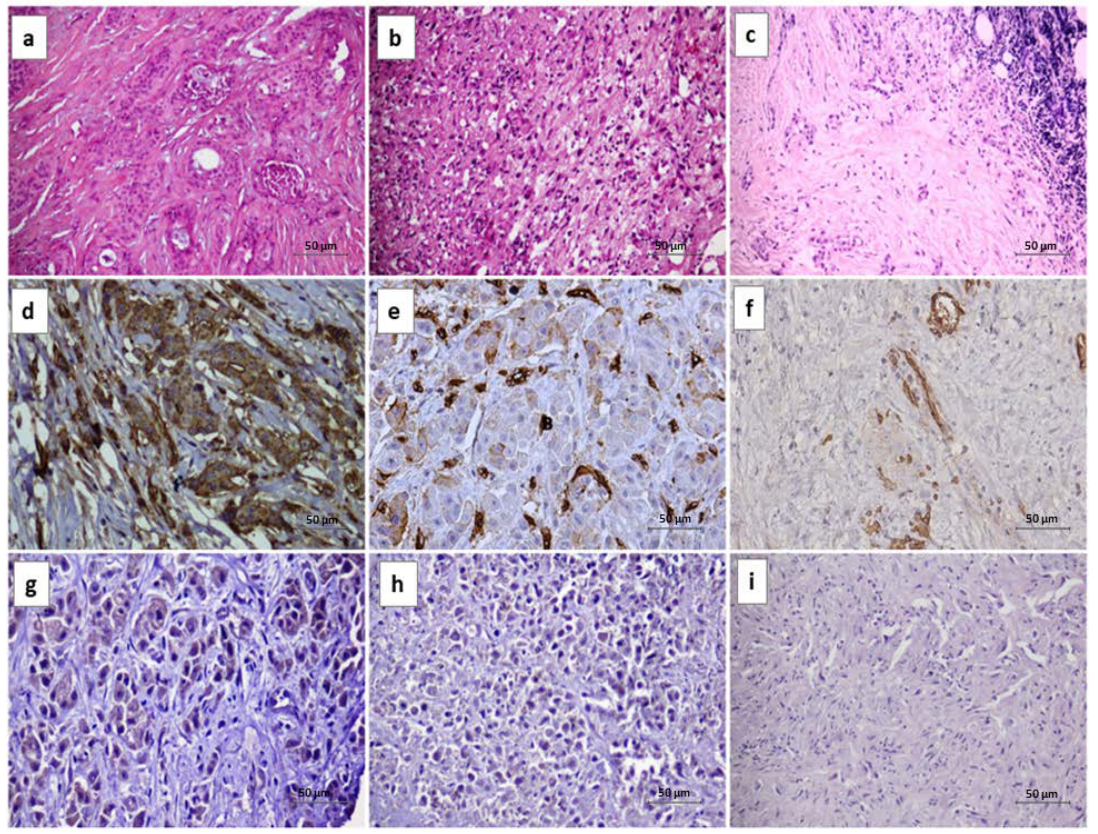
Figure 1. Representative Hematoxylin and Eosin staining and IHC results (original magnification 40×). ( a ) epithelial malignant pleural mesothelioma; ( b ) sarcomatoid malignant pleural mesothelioma; ( c ) biphasic malignant pleural mesothelioma; ( d ) AXL IHC positive staining score 3+; ( e ) AXL IHC positive staining score 2+; ( f ) AXL IHC positive staining score 1+; ( g ) MET IHC positive staining score 3+; ( h ) MET IHC positive staining score 2+; ( i ) MET IHC positive staining score 1+.